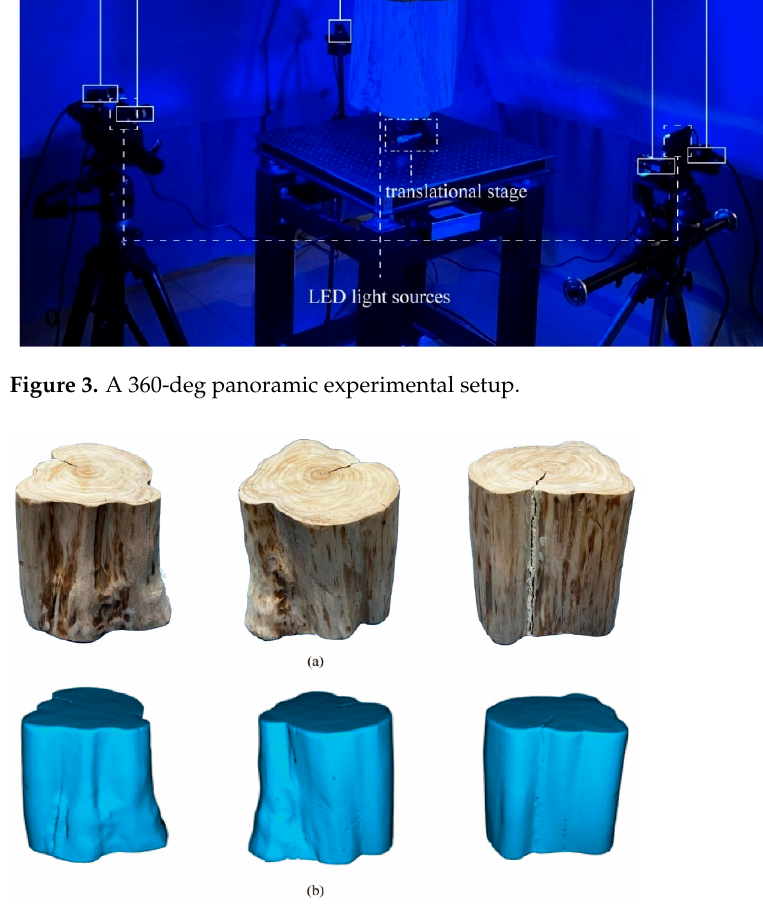
Figure 4. The test specimen and the scanning point cloud of the test specimen. ( a ) The test specimen at different viewpoints. ( b ) The scanning point cloud of the same viewpoints in ( a ).